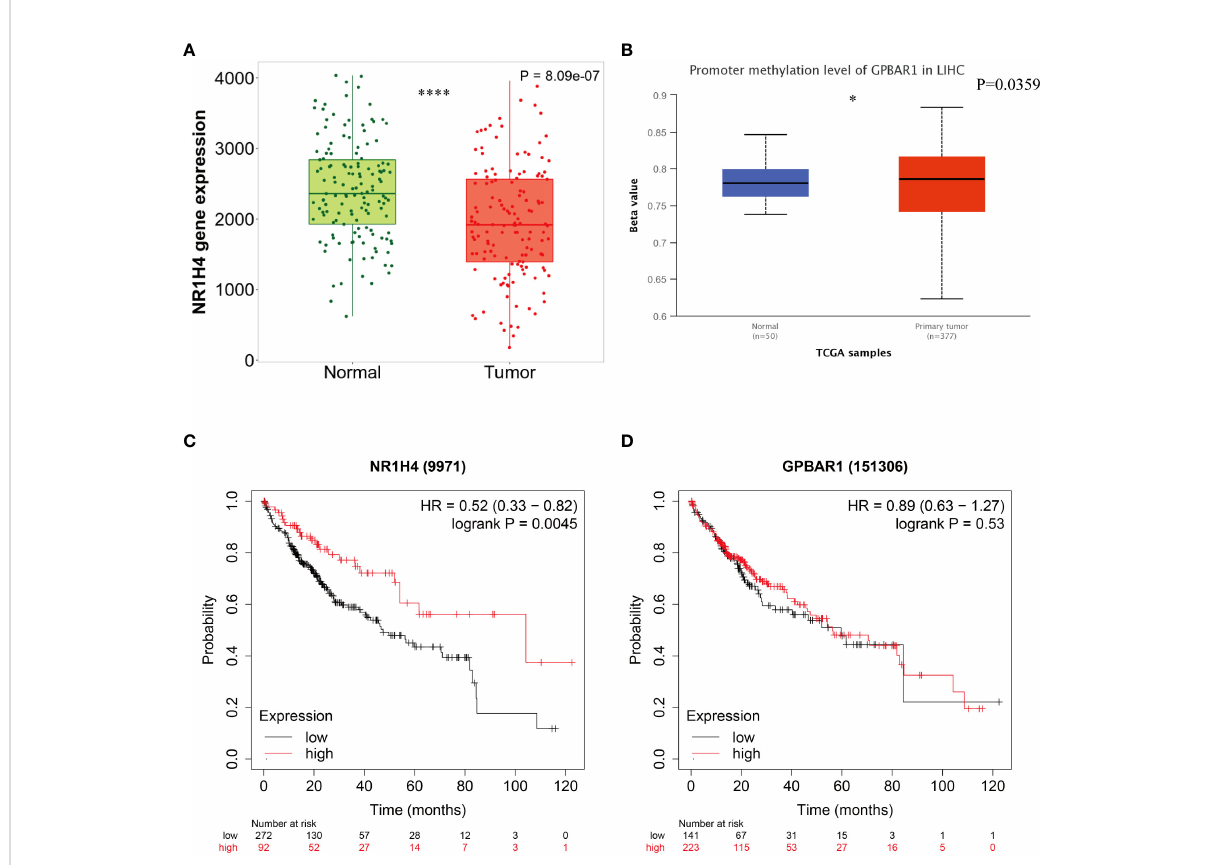
FIGURE 2 Survival curves according to the expression of bile acids- activated receptors. (A) Comparative analysis of mRNA expression of FXR between HCC tissue and normal tissues. (B) Promoter methylation level of TGR5 in HCC. Kaplan-Meier curves for overall survival according to the expression of FXR (C) and TGR5 (D) . *P < 0.05 ;**** P <